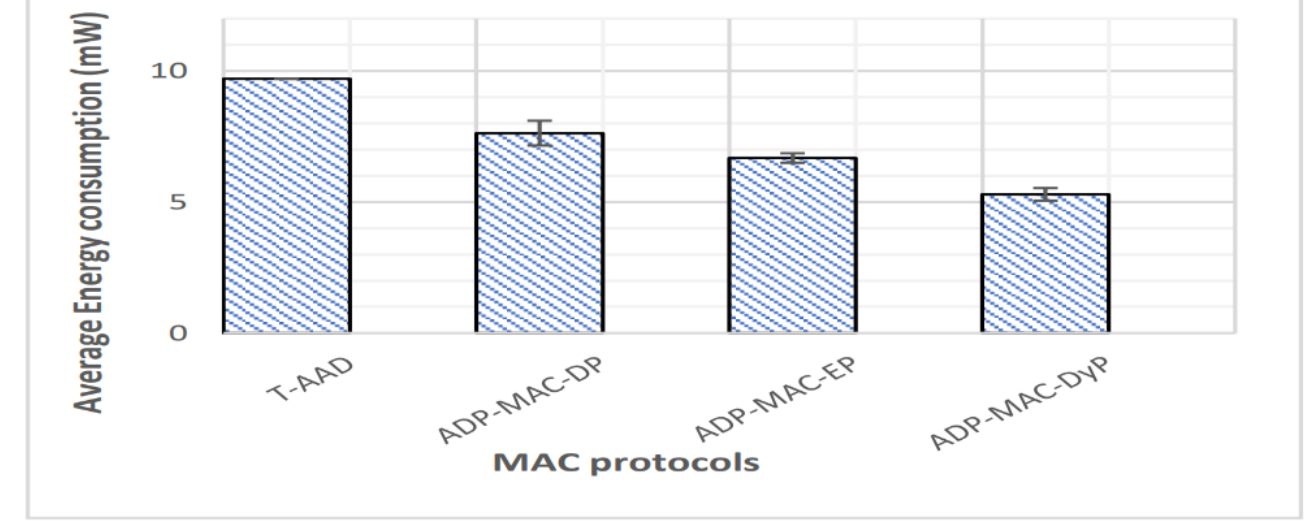
Fig. 6. Energy performance comparison of ADP-MAC with